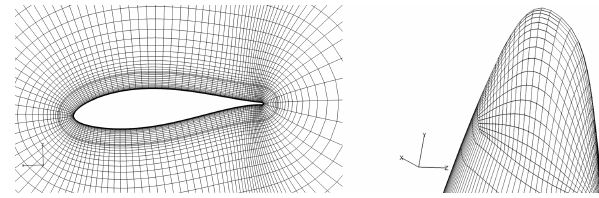
Figure 5. Near-rotor mesh at 25m span and surface discretization at tip. Only every second line